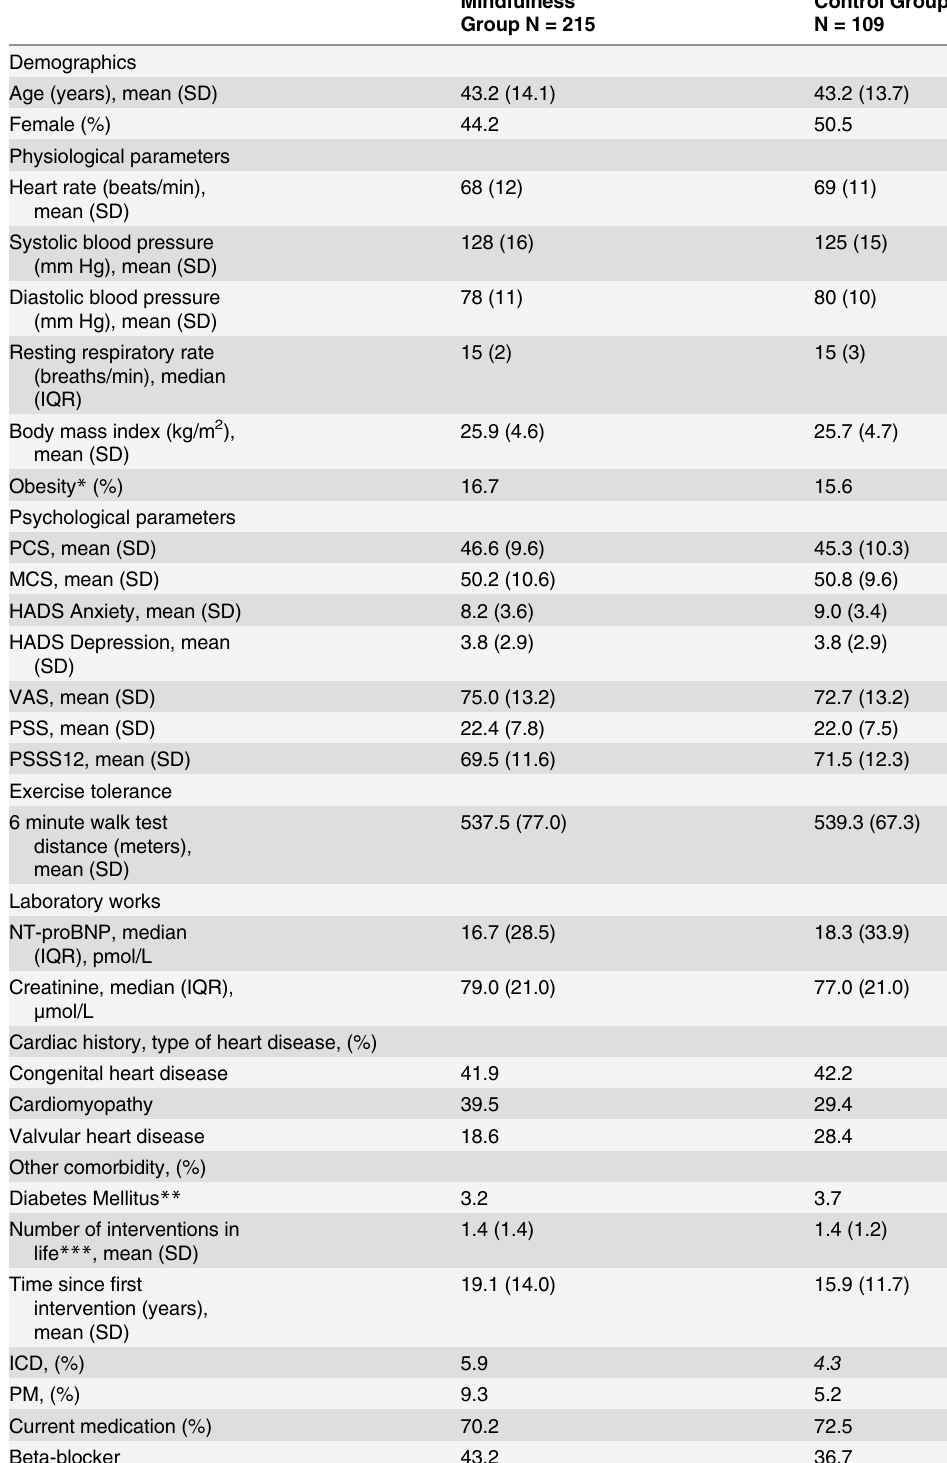
Table 1. Baseline characteristics of study